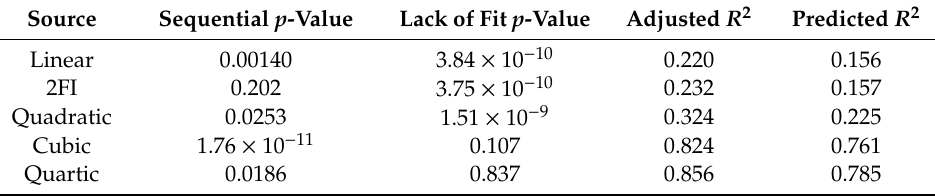
Table 7. Summary of the comparison between models for the τ b parameter for photo-bending.